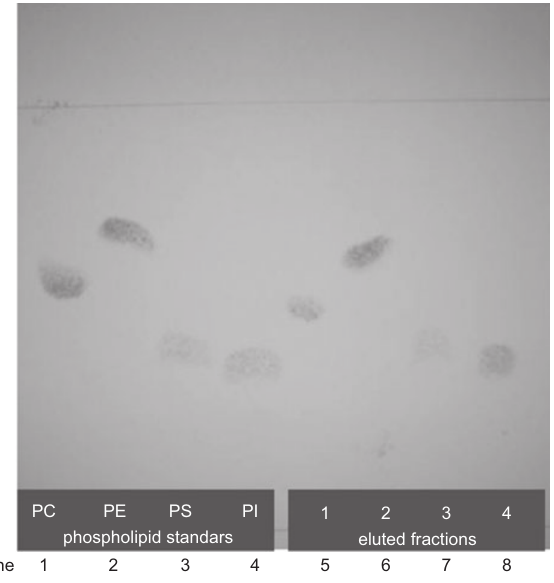
Figure 2 TLC plate of eluted PL fractions from the longissimus dorsi muscle of rats obtained following the Banni et al. (2001) modi- fi ed method by Perez-Palacios et al. Reprinted from Food Chemistry, 102, Perez-Palacios T., Ruiz J., Antequera T., Improvement of a